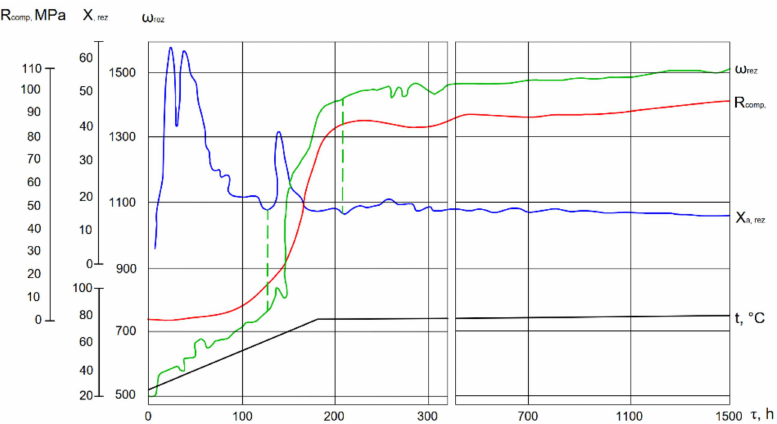
Figure 10. The influence of Portland cement clinker on the structure formation of the cement in